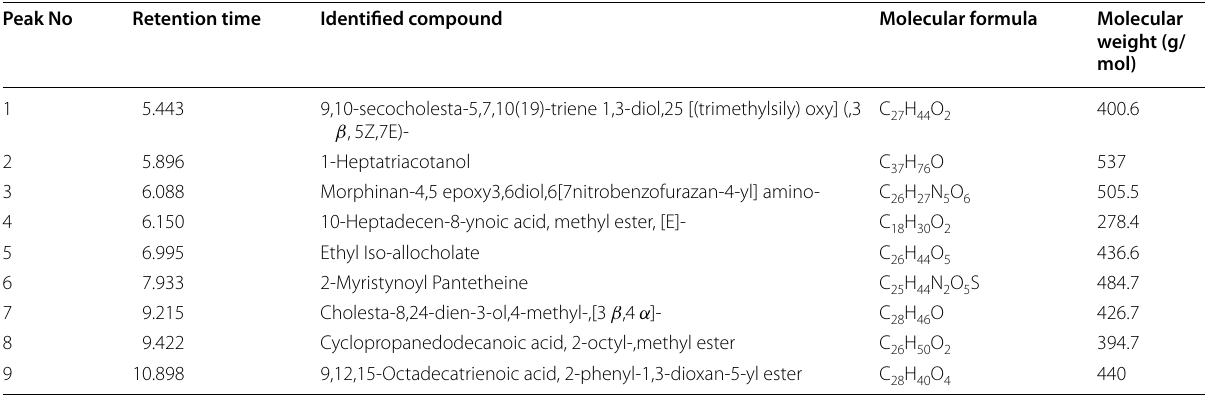
Table 2 GCMS analysis of Eucalyptus globulus leaf extract Peak No Retention time Identified